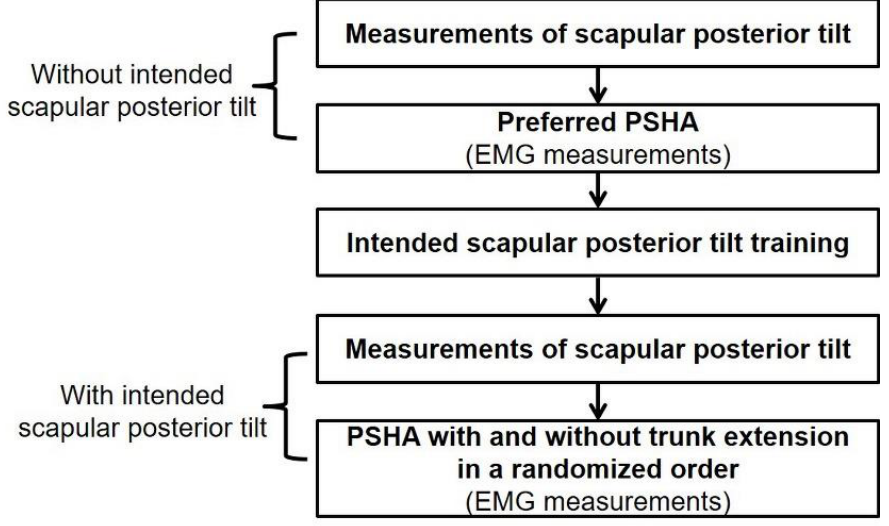
Figure 5. Flow diagram of the experimental procedures. Abbreviations: PSHA, prone shoulder horizontal abduction.